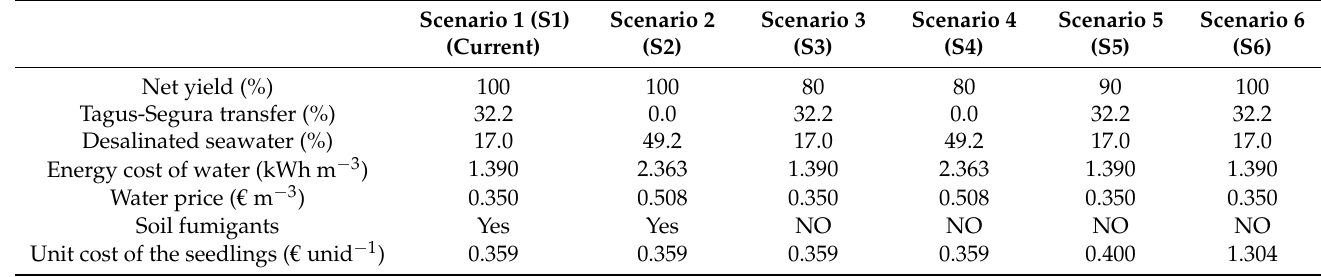
Table 3. Scenarios evaluated in the economic and environmental sensitivity